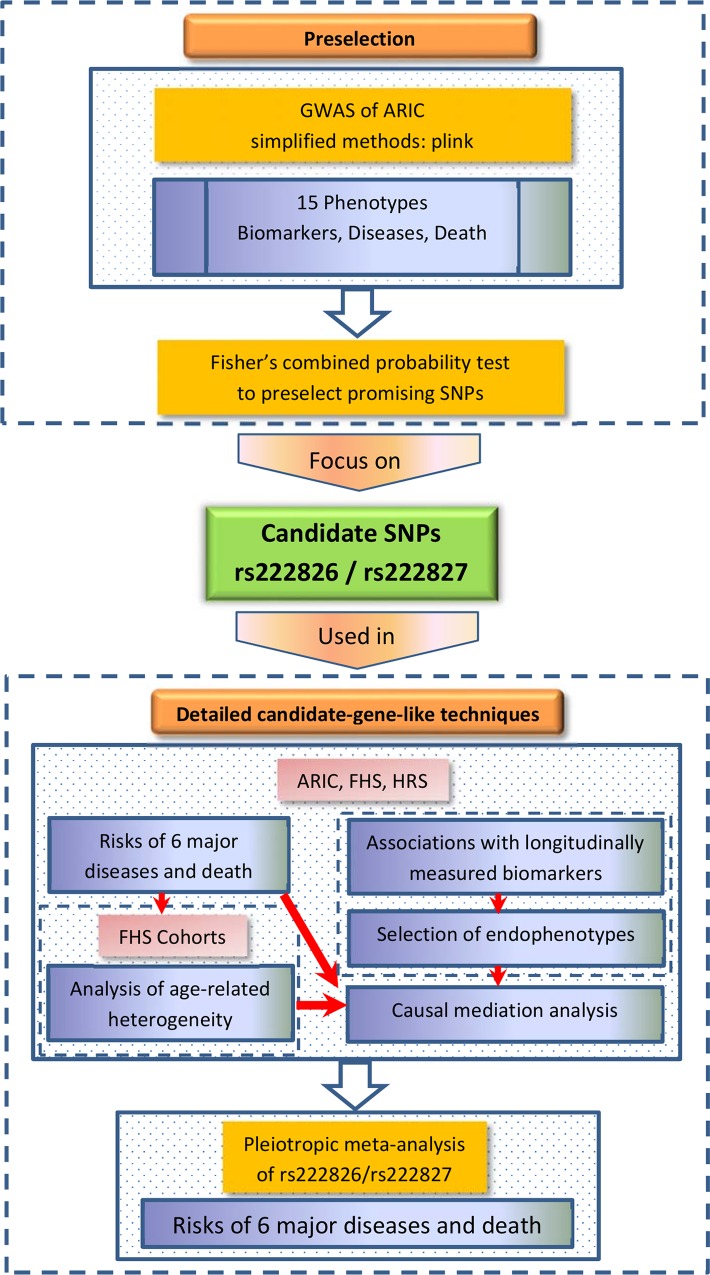
A flowchart of the analyses in this study.All analyses were conducted for whites. Major focus of these analyses was on two uncommon SNPs with minor allele frequency (MAF) ~2.5%. Given this MAF and the available sample size in ARIC, FHS, and HRS, the analyses were conducted for men and women combined to increase the sample of the minor allele carriers.